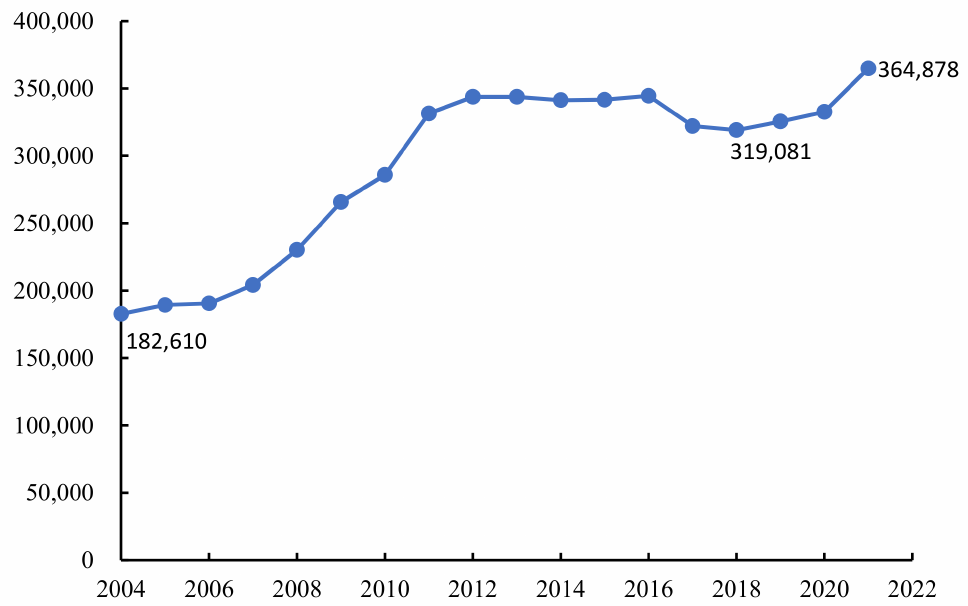
Figure 4. The output of Chinese soft-shelled turtles from 2004 to 2021 (unit: